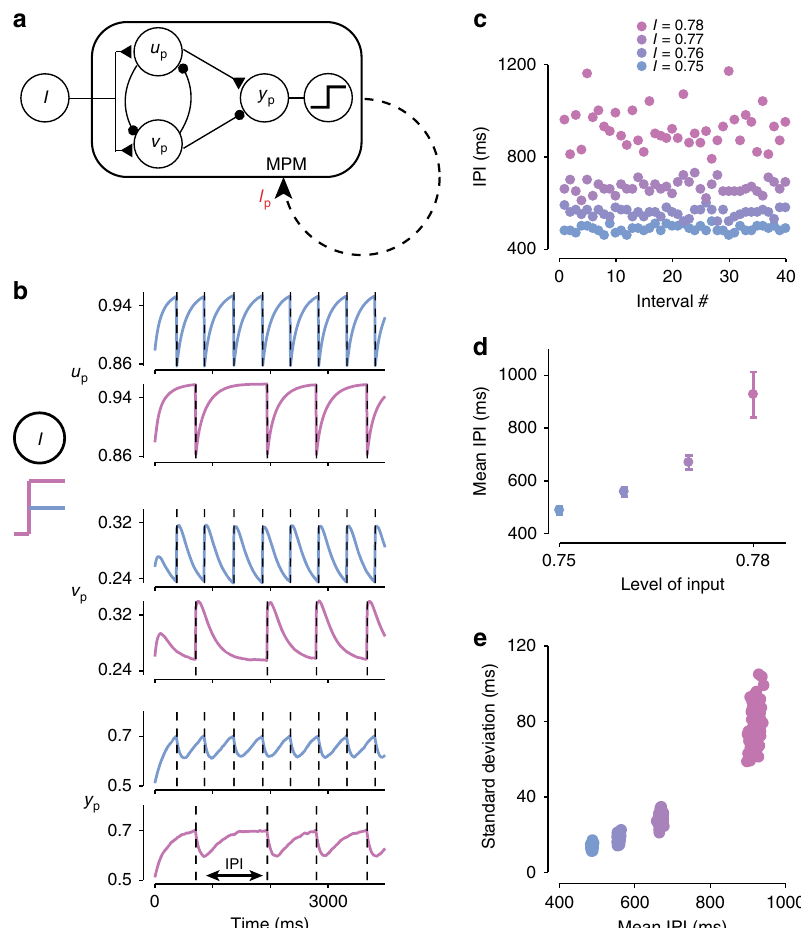
Fig. 2 Input to the motor planning module (MPM) controls frequency of periodic production. a The architecture of the MPM is identical to the BCM, with the addition of a reset mechanism that is activated when y p crosses the threshold (represented by the nonlinear unit at right), and causes the output to be fed back as an input, I p (dashed line). Excitatory and inhibitory connections are shown by triangles and circles, respectively. b Behavior of the units u p , v p and y p in response to a small (blue) or large (pink) input, I . Vertical dashed lines indicate the timing of threshold crossing and motor output. The time between successive motor outputs is de fi ned as the inter-production-interval (IPI). c Value of the fi rst 40 IPIs generated by the MPM at each level of input, I (colors), in representative trials. d Mean of the IPIs (±standard deviation; N = 40) in panel ( c ) as a function of input, I . e Standard deviation of IPIs plotted against the mean IPI for 100 trials of each level of input in the presence of Gaussian noise ( σ n = 0.01). Each data point represents the results of a trial as in panels ( c ) and ( d